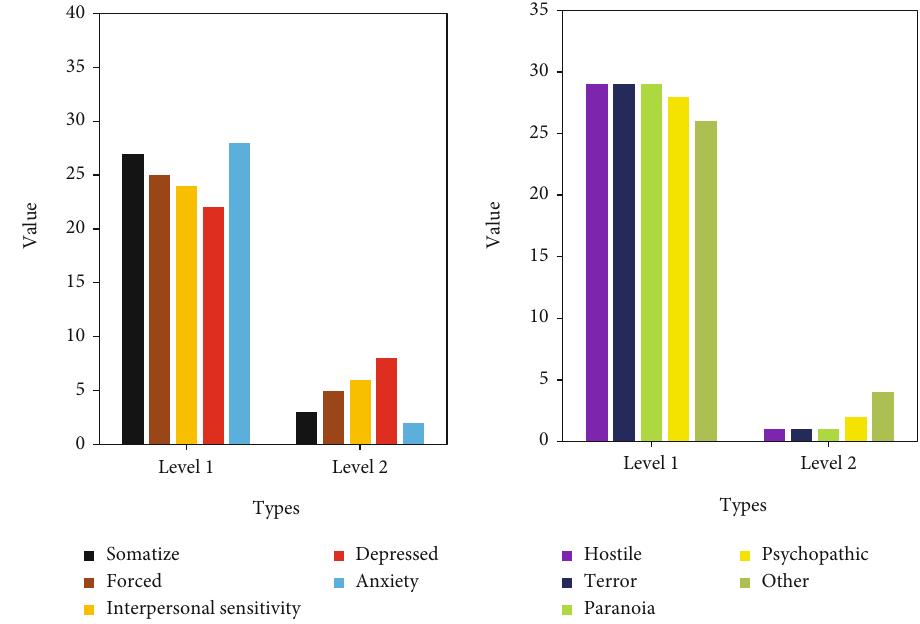
Figure 5: Score frequency distribution of SCL total mean and each factor mean. Table 2: Frequency and percentage of SDS total score and single factor score (1).